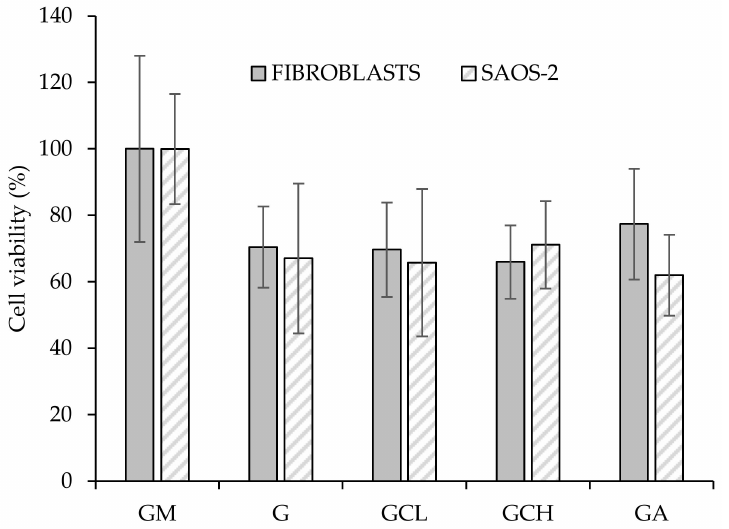
Figure 7. Cytocompatibility of fibroblasts and human primary osteogenic sarcoma cells (SAOS-2) grown for 6 days onto the scaffolds (mean values ± sd; n = 5). Abbreviation: GM growth